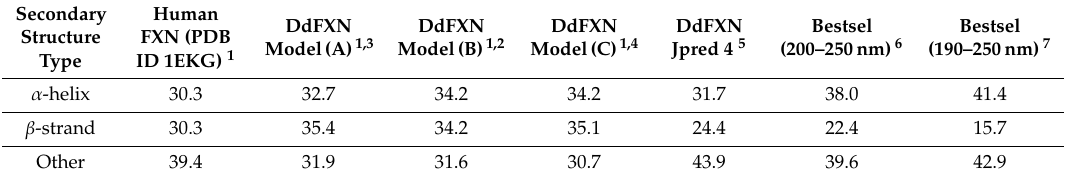
Table 2. Secondary Structure content of